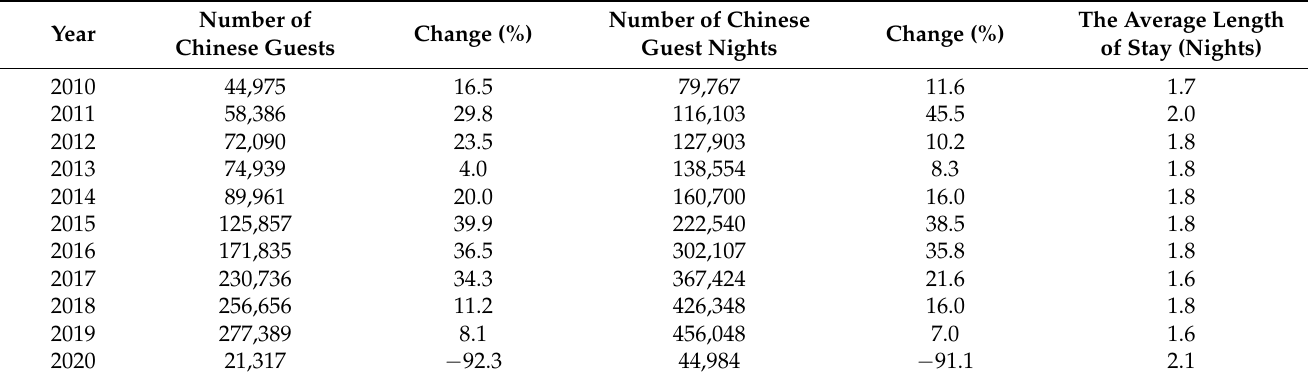
Table 2. Visitor turnover indicators of Chinese tourists arriving in Hungary,